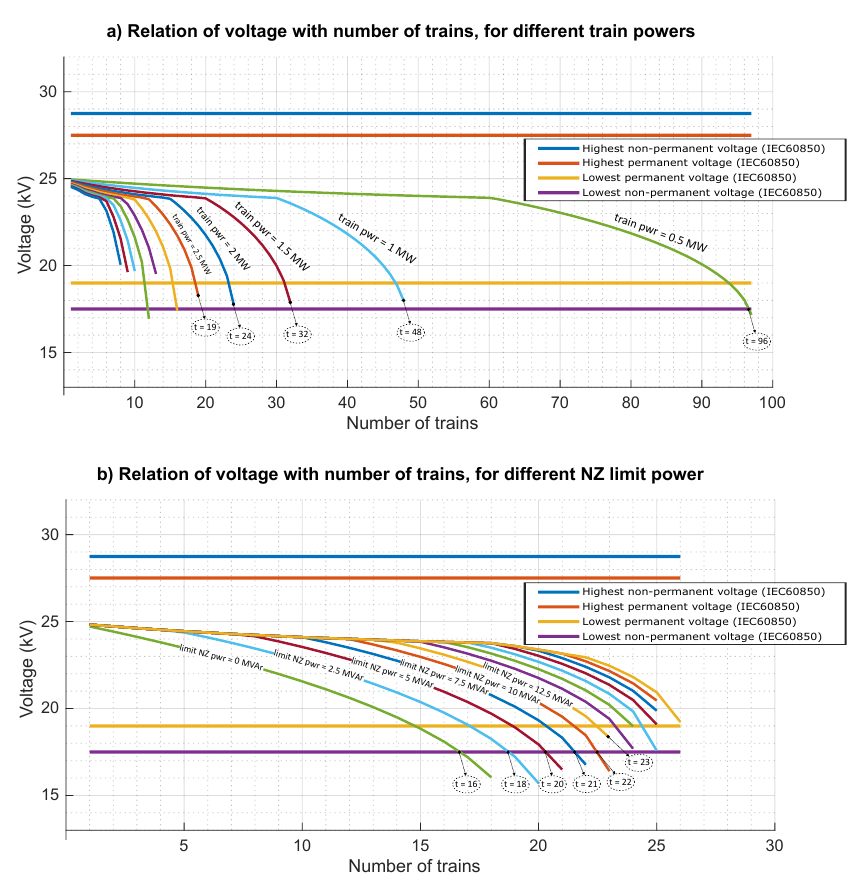
Figure 14. Relation of number of trains ( PF = 0.98 ind.) with lower voltage in line: ( a ) variation of active power in each train, for fixed NZ limit power (15 MVA maximum power, as example, visible after 30 trains for 1 MW train power); ( b ) variation of NZ limit power, for fixed train active power of 2